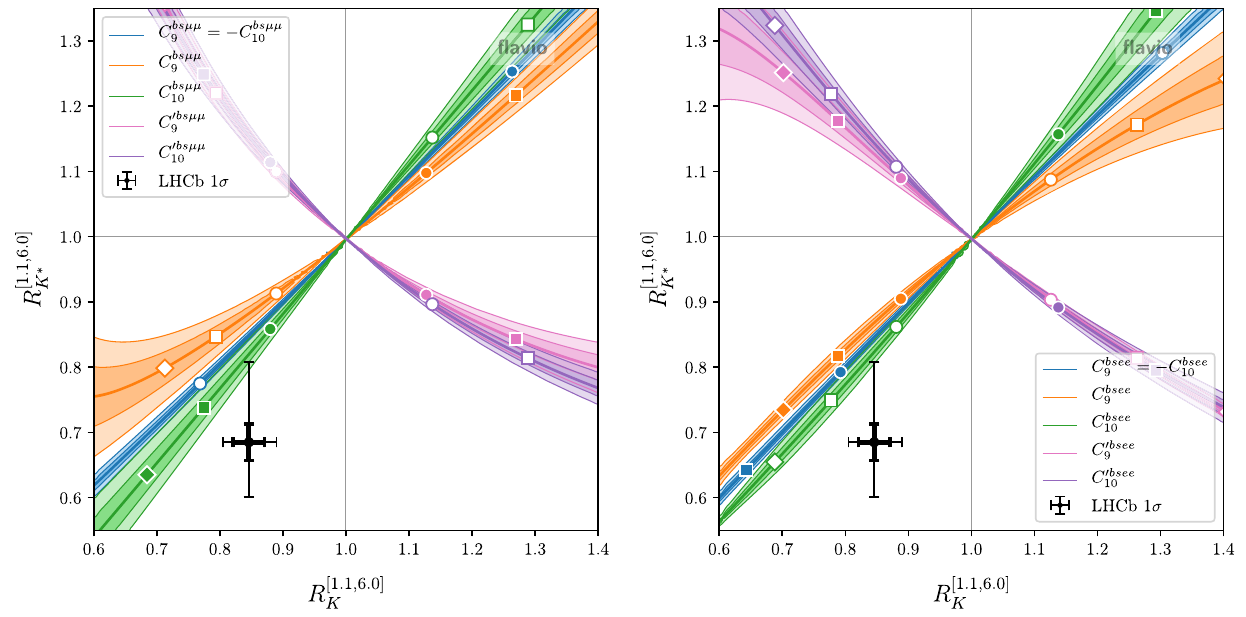
Fig. 1 Theory predictions for R K and R K ∗ in the presence of various non-standardWilsoncoefficients(left:newphysicsinmuons;right:new physics in electrons). The colored bands correspond to the 1 σ and 2 σ theory uncertainties. Circle, square, and diamond markers correspond